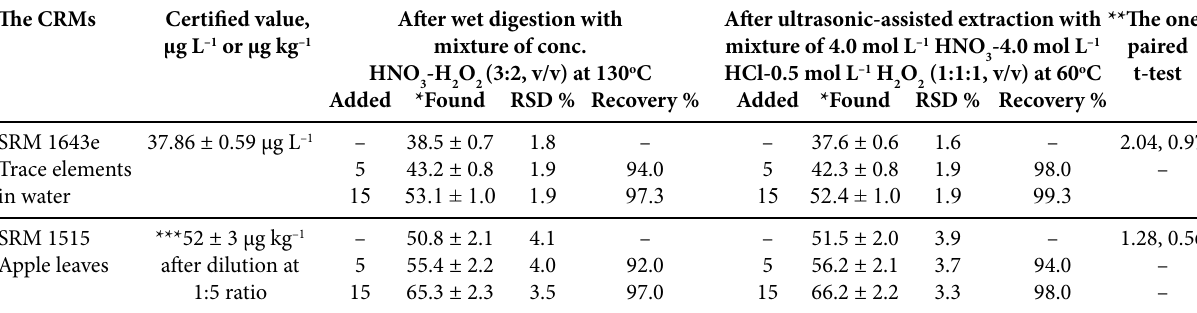
Table 3. (a) The verification of the method accuracy by the replicate measurements of total V levels in the selected CRMs without and with spiking at levels of 5 and 15 µg L –1 after pretreatment and dilution (n: 5) The CRMs